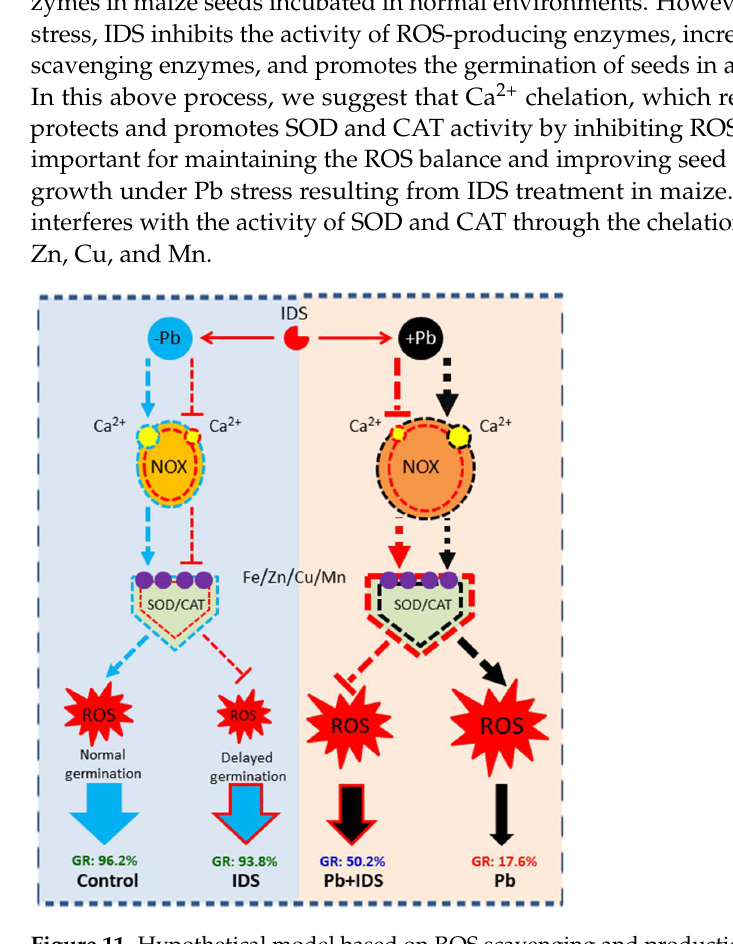
Figure 11. Hypothetical model based on ROS scavenging and production illustrating IDS-regulated seed germination processes under Pb-free (−Pb) and Pb-stressed (+Pb) conditions. The blue dotted line indicates the control treatment (distilled water), the black dotted line indicates treatment with Pb stress, and the red dotted line indicates treatment with IDS. Pointed and blunt dashed arrows represent the positive and negative effects of these treatments, respectively. The thickness of the dotted line indicates the degree of influence of different treatments on relevant indicator values. Pb, lead; ROS, reactive oxygen species; IDS, iminodisuccinic acid; NOX, NADPH oxidase; SOD, super- oxide dismutase; CAT, catalase; GR, germination rate.